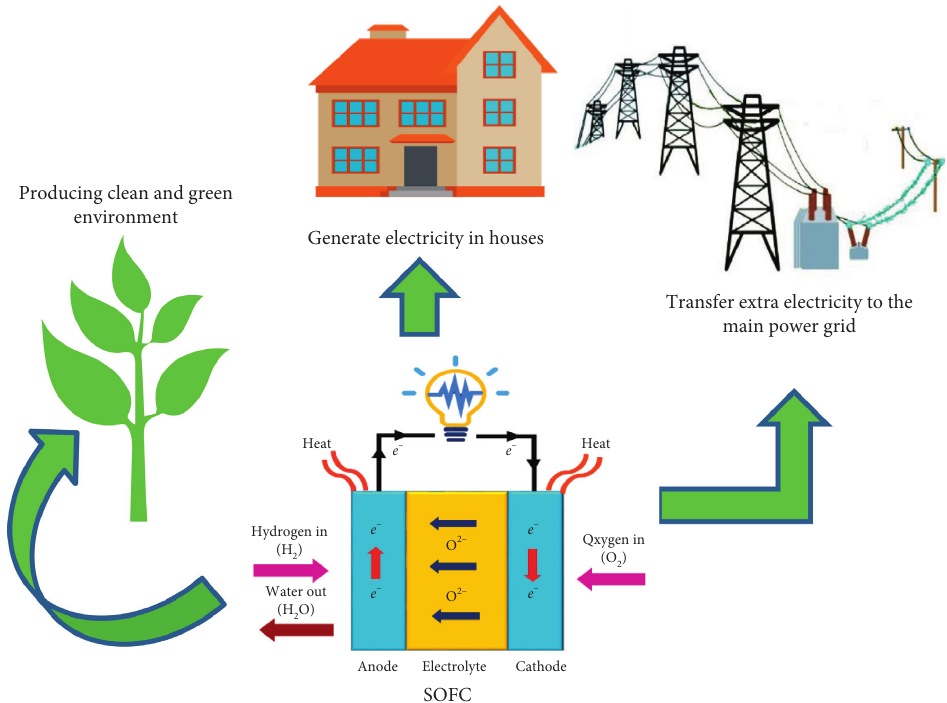
Figure 4: Schematic diagram of generating electricity through SOFC